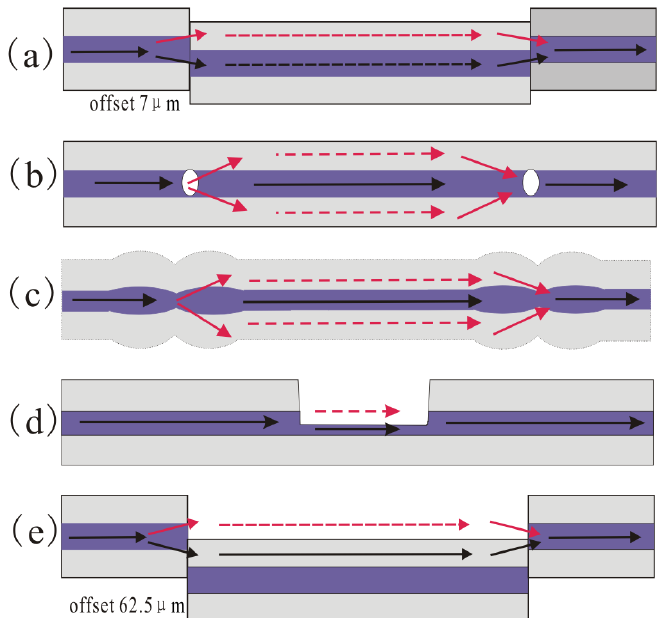
Figure 9. Configuration of various types of in-line MZIs; the methods of using ( a ) core-offset structure; ( b ) air-hole formed by femtosecond laser; ( c ) peanut-shape structure; ( d ) open air cavity formed by femtosecond laser; ( e ) open air cavity formed by large lateral offset splicing.